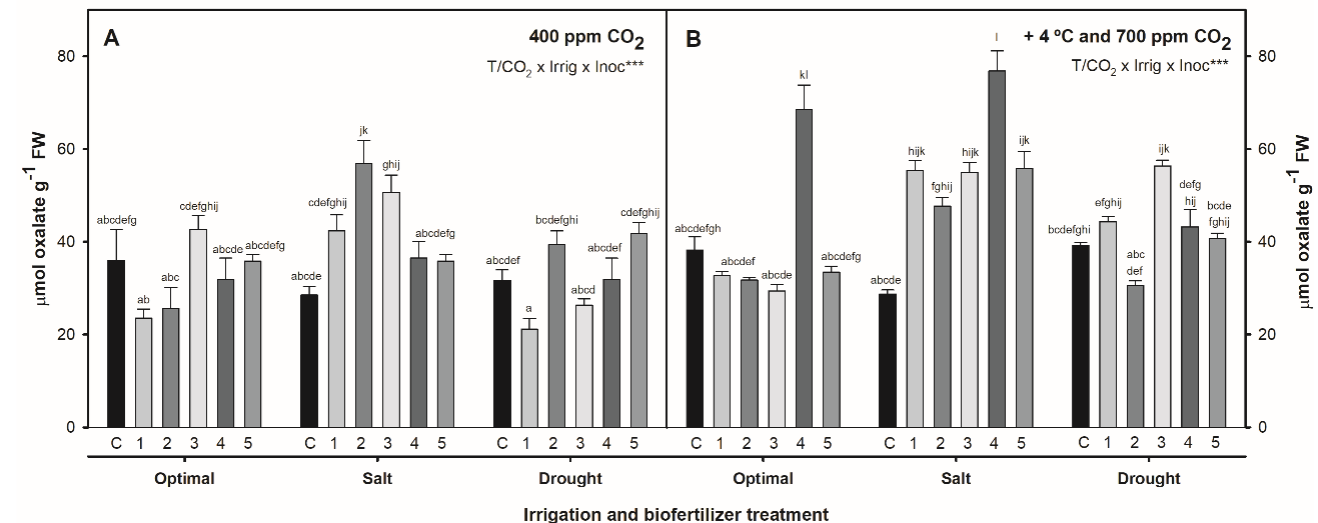
Figure 3. Oxalate content in S. ramosissima shoots, as expressed by µmol oxalate g −1 FW, after 30 days under irrigation (optimal 171 mmol L −1 NaCl, salinity 510 mmol L −1 NaCl, and drought) and inoculation (control non-inoculated — C, and biofertilizers 1 to 5) treatments in ( A ) 25/14 °C 400 ppm CO 2 chamber and ( B ) 29/18 °C 700 ppm CO 2 chamber. Values are means ± S.E. (n = 3). Different letters indicate means that are significantly different from each other (GLM: T/CO 2 × Irrigation × Inoculation, p < 0.001). “T/CO 2 × Irrig × Inoc” in the upper right corner of the pa nels indicates triple interaction significant effects ( p *** < 0.001).